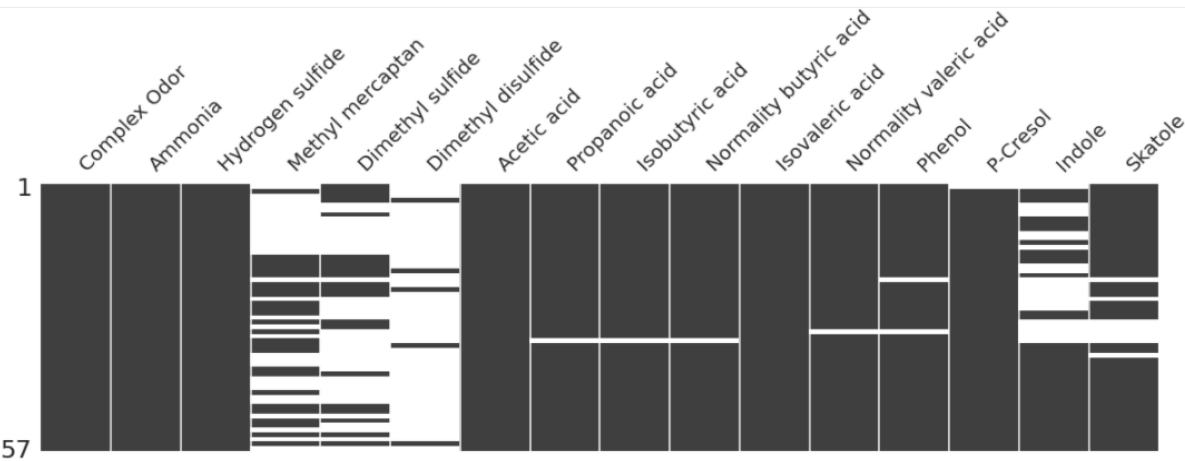
Figure 1. Map of missing data.